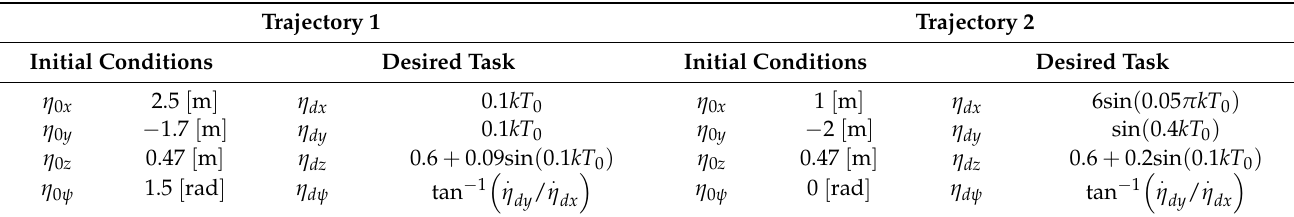
Table 6. Desired trajectory and initial parameters.